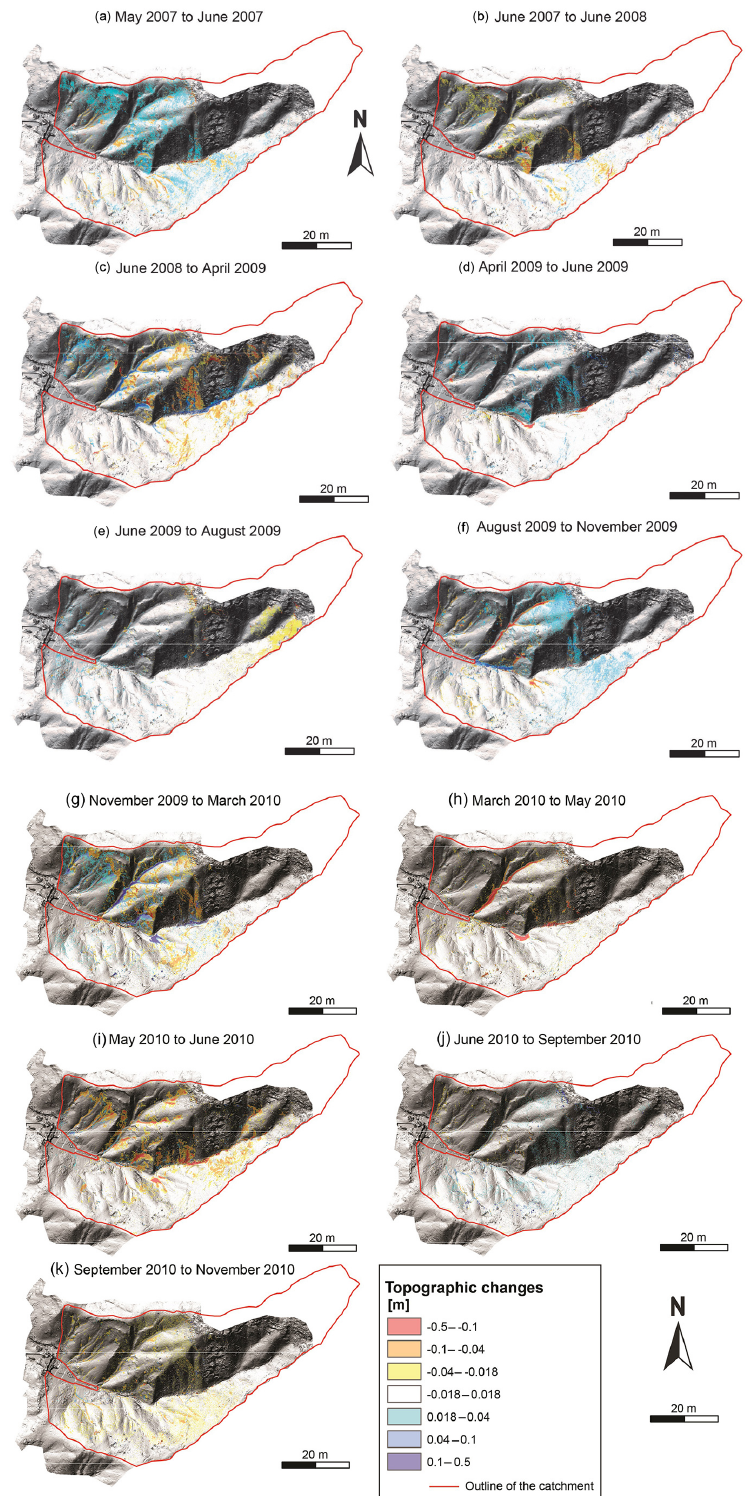
Figure 2. Observed height differences for the period 2007–2010 highlighting the soil surface changes of La Roubine catchment. The red outline indicates the boundary of the catchment (see large version in the